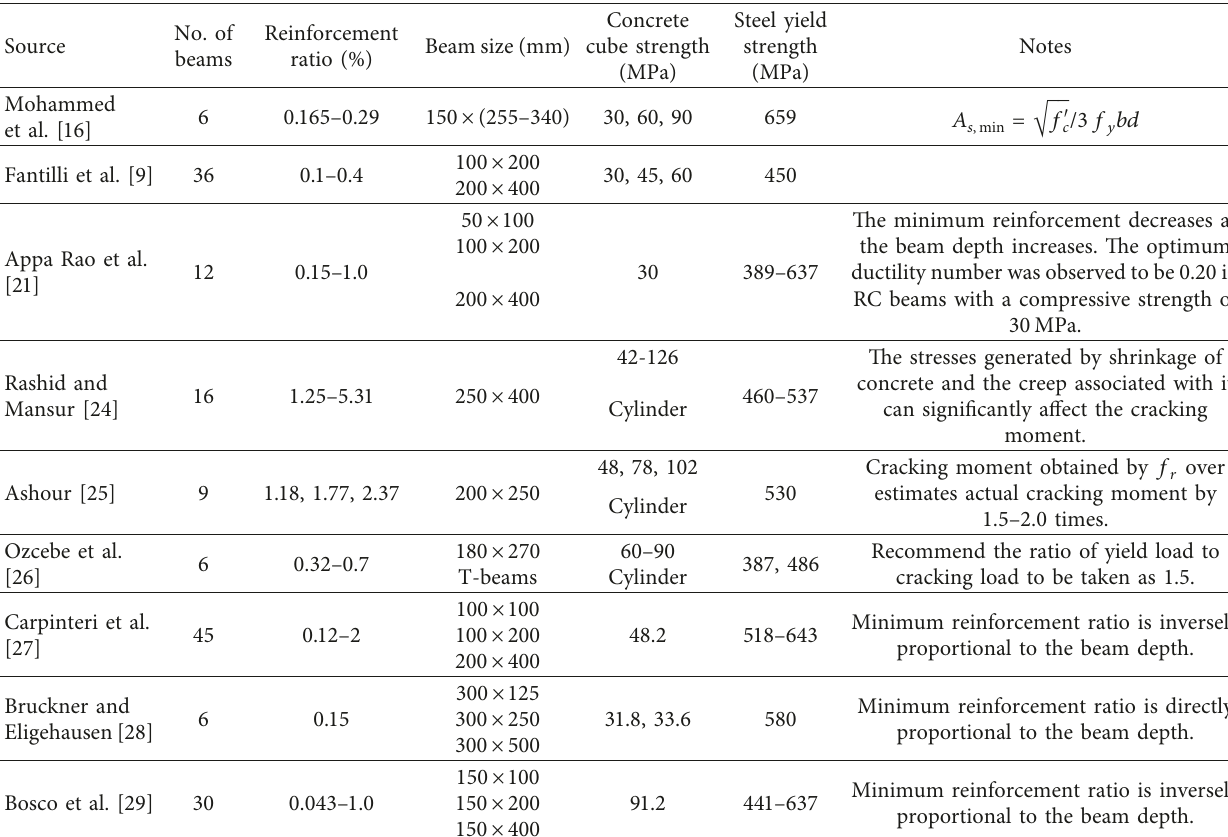
Table 3: Summary of the literature empirical studies on minimum flexural reinforcement limit